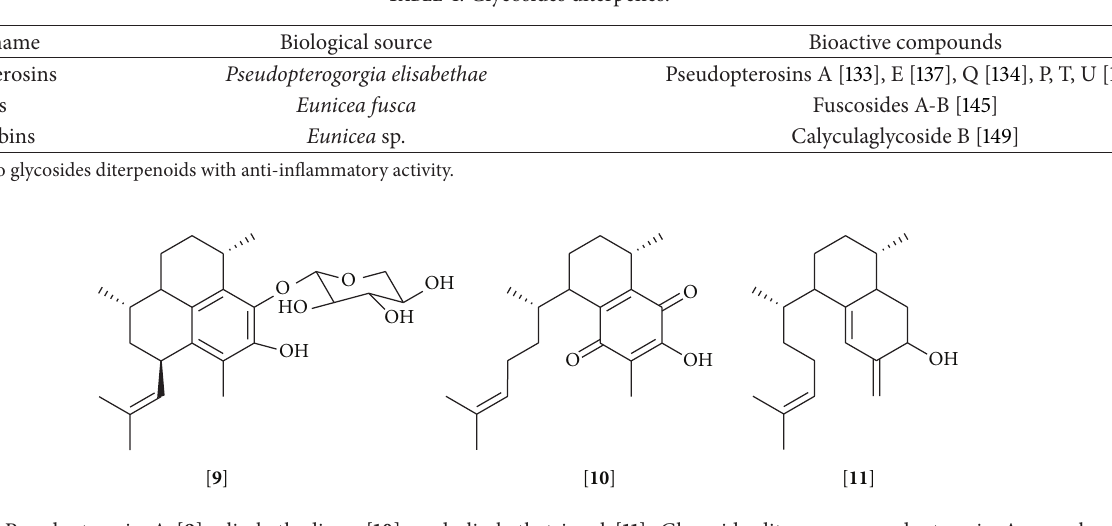
Figure 5: Pseudopterosin A [ 9 ], elisabethadione [ 10 ], and elisabethatrienol [ 11 ]. Glycoside diterpene, pseudopterosin A, nonglycoside diterpenes, elisabethadione, and